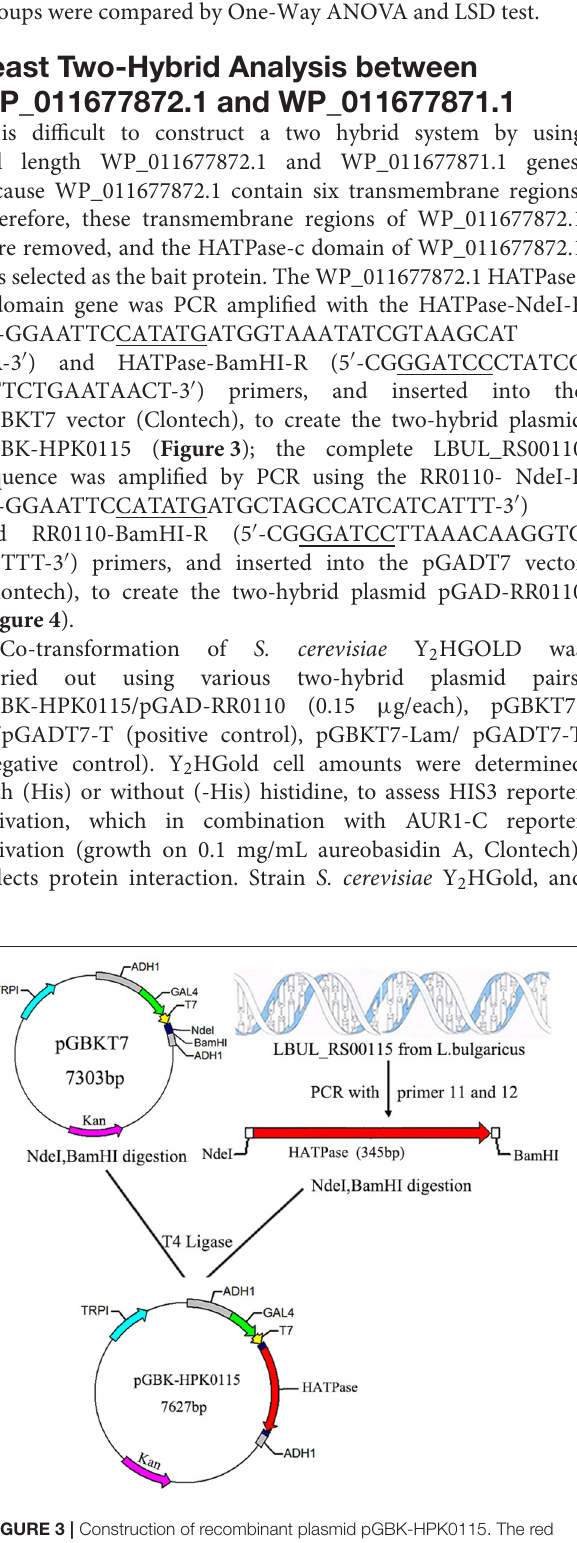
Frontiers in Microbiology |